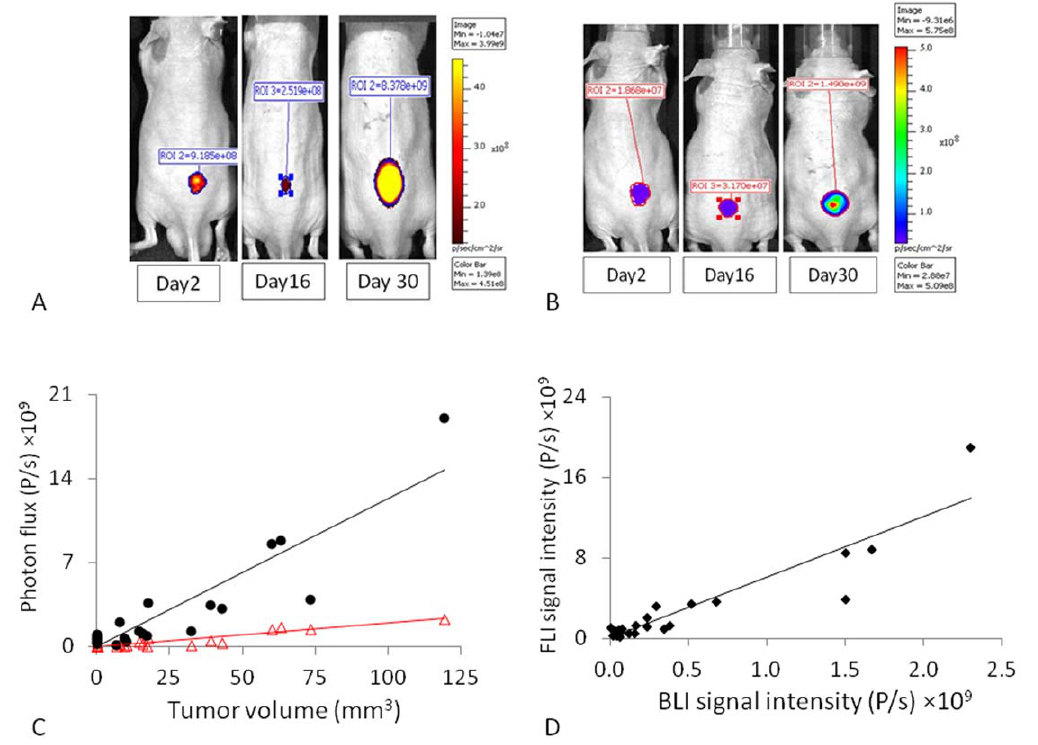
Figure 1. Optical detection of U87-mCherry-luc tumor growth. A) FLI ( l Ex =570 nm and l Em =620 nm) showed tumor growth on the back of a nude mouse. B) Corresponding BLI acquired 10 mins after administration of sodium D -luciferin (80 m L, 40 mg/ml). C) Correlation between signal intensities and caliper measured tumor volume for a group of six U87-mCherry-Luc tumors; FLI ( between FLI and BLI photon signal intensities at each measurement time (R 2 .